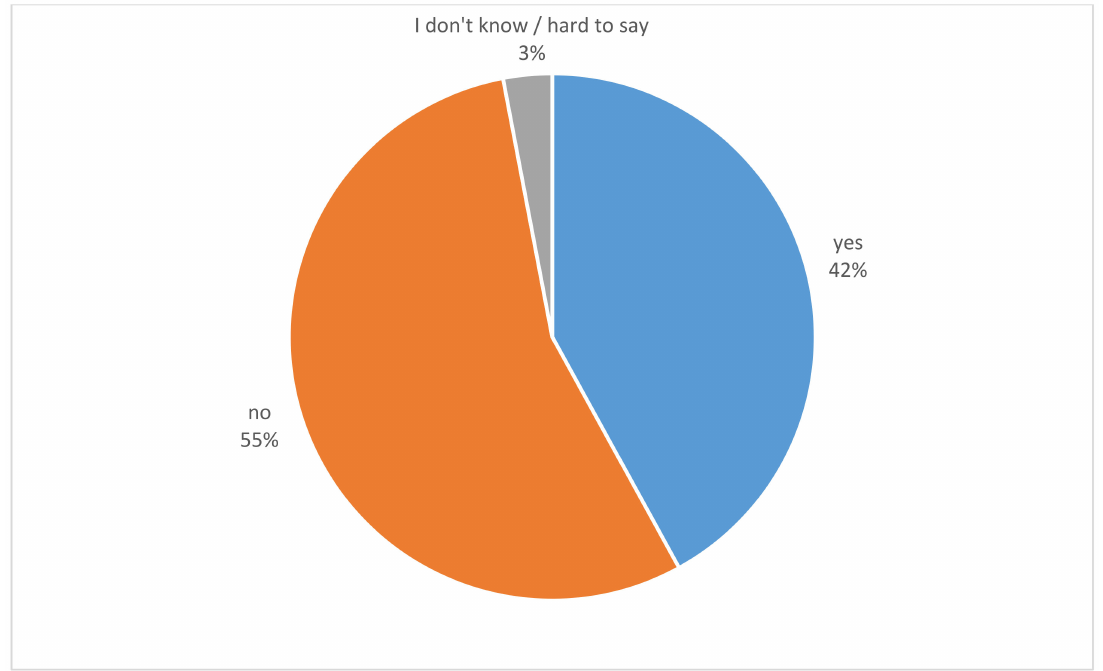
Figure 1. The natural causes that have always occurred on Earth are primarily responsible for climate